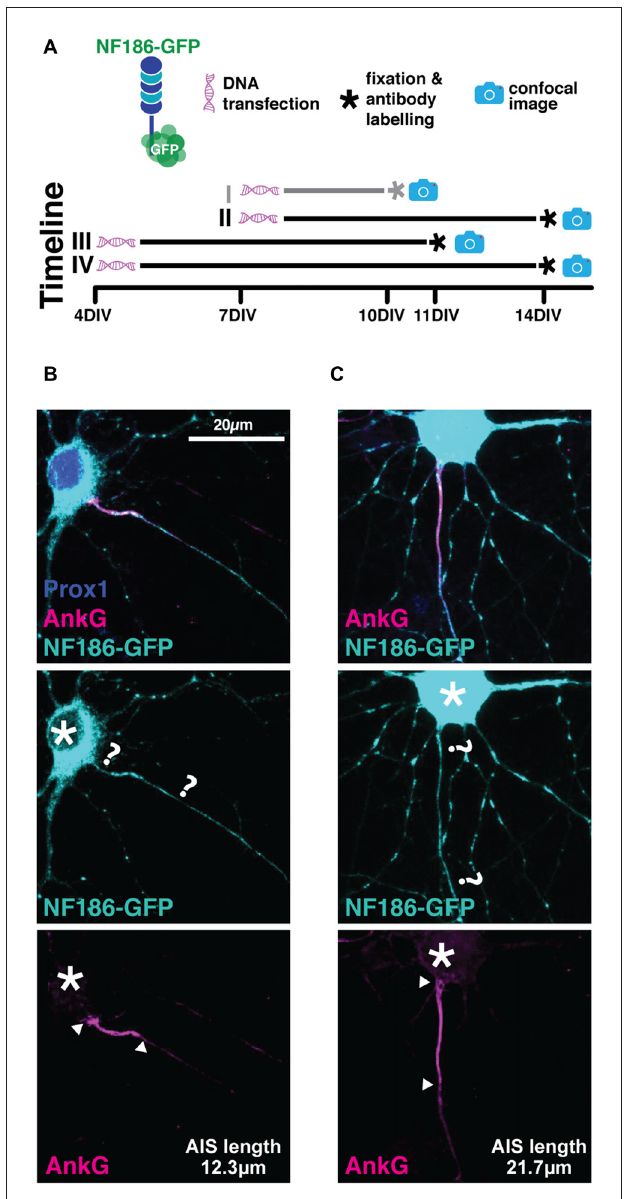
FIGURE 4 | NF186-GFP does not localize specifically to the AIS. (A) Diagram of experimental timeline for all the four transfection methods attempted (see Table 2 ); gray line highlights method used for the cells displayed in panel (B,C) . (B) Maximum intensity projection of the best observed co-localization between the NF186-GFP construct (cyan) and AnkG (magenta). Asterisks, soma; question marks, putative start and end of NF186-GFP-labeled AIS; arrowheads, AnkG-labeled AIS start and end positions. (C) As in (B) , but showing the most commonly observed expression pattern of